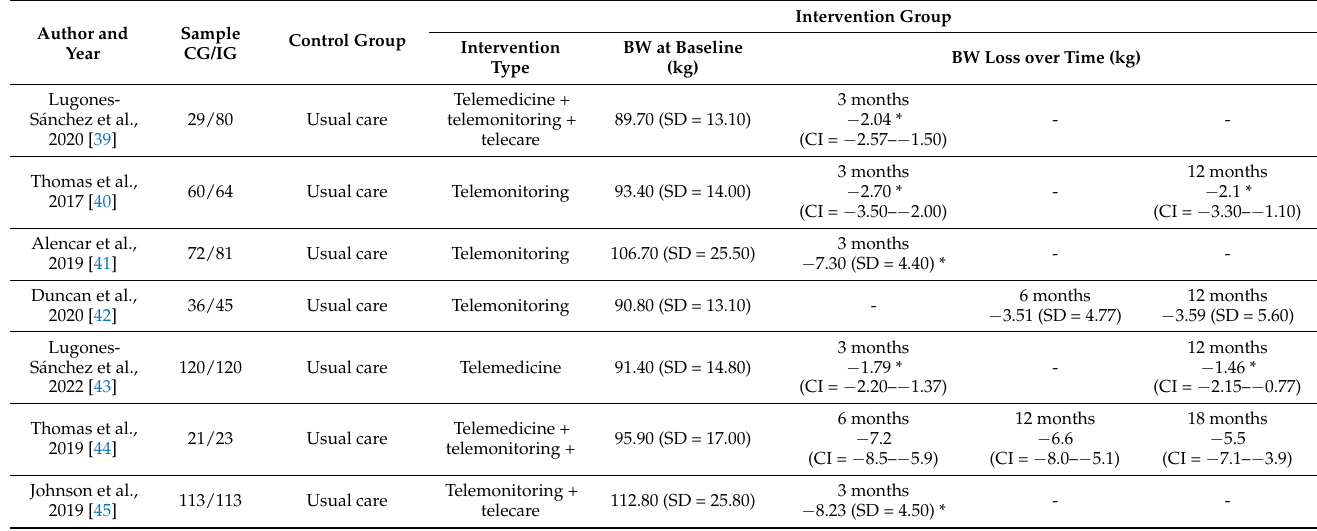
Table 4. Effects of telemedicine-based interventions in persons with overweight.